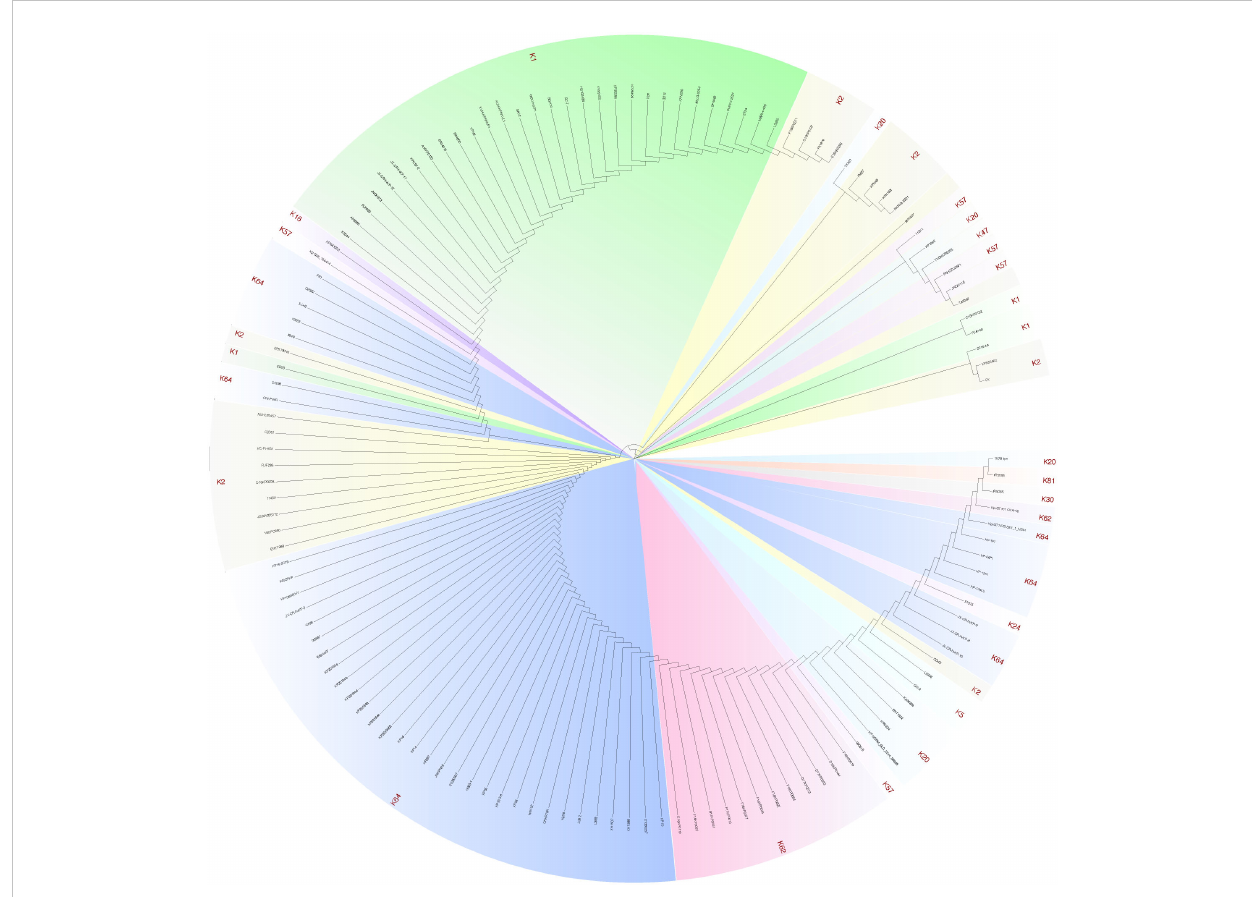
FIGURE 7 Sequence diversity of rmpA among hvKp strains, illustrated by the phylogenetic tree of rmpA sequences in various serotypes of hvKp strains. The tree was constructed using the maximum likelihood method with 1,000 bootstrap replicates in the MEGA7 software